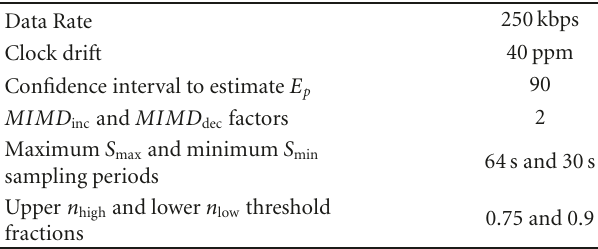
Table 1: Performance evaluation parameters.